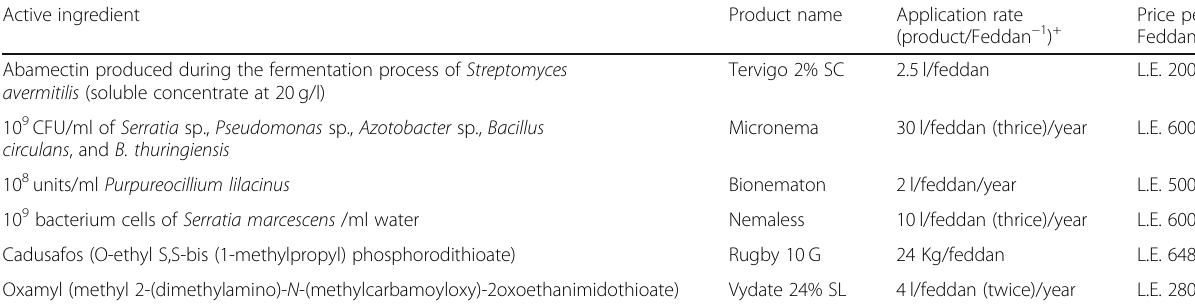
Table 1 Key commercially available bionematicides and chemical nematicides, their applications rates, and prices in Egypt Active